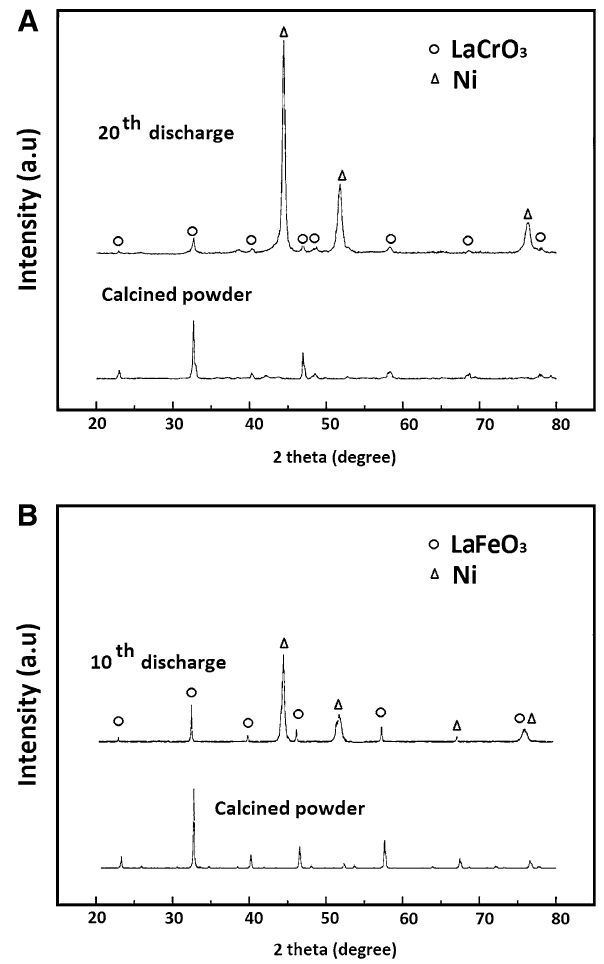
Fig. 6 XRD patterns of the calcined and discharged perovskite-type electrodes, a LaCrO 3 composition, b LaFeO 3 composition. Ni peaks correspond to the presence of nickel powder added as a binder. Data adapted from [27, 78]